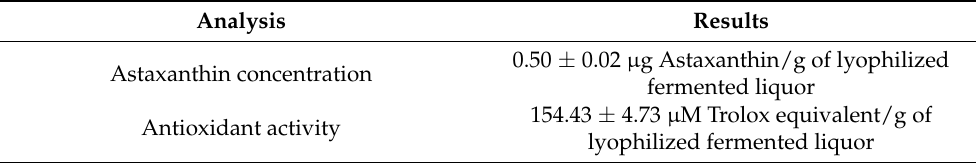
Table 3. Lipophilic antioxidants of the lyophilized liquor produced from fermented shrimp